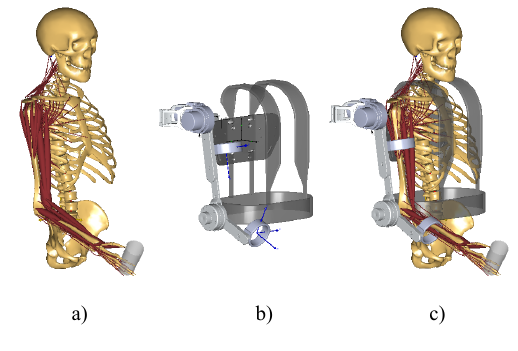
Figure 2: Model of the human-exoskeleton system: a) the human biomechanics, b) the exoskeleton model, c) the cooperative human-exoskeleton